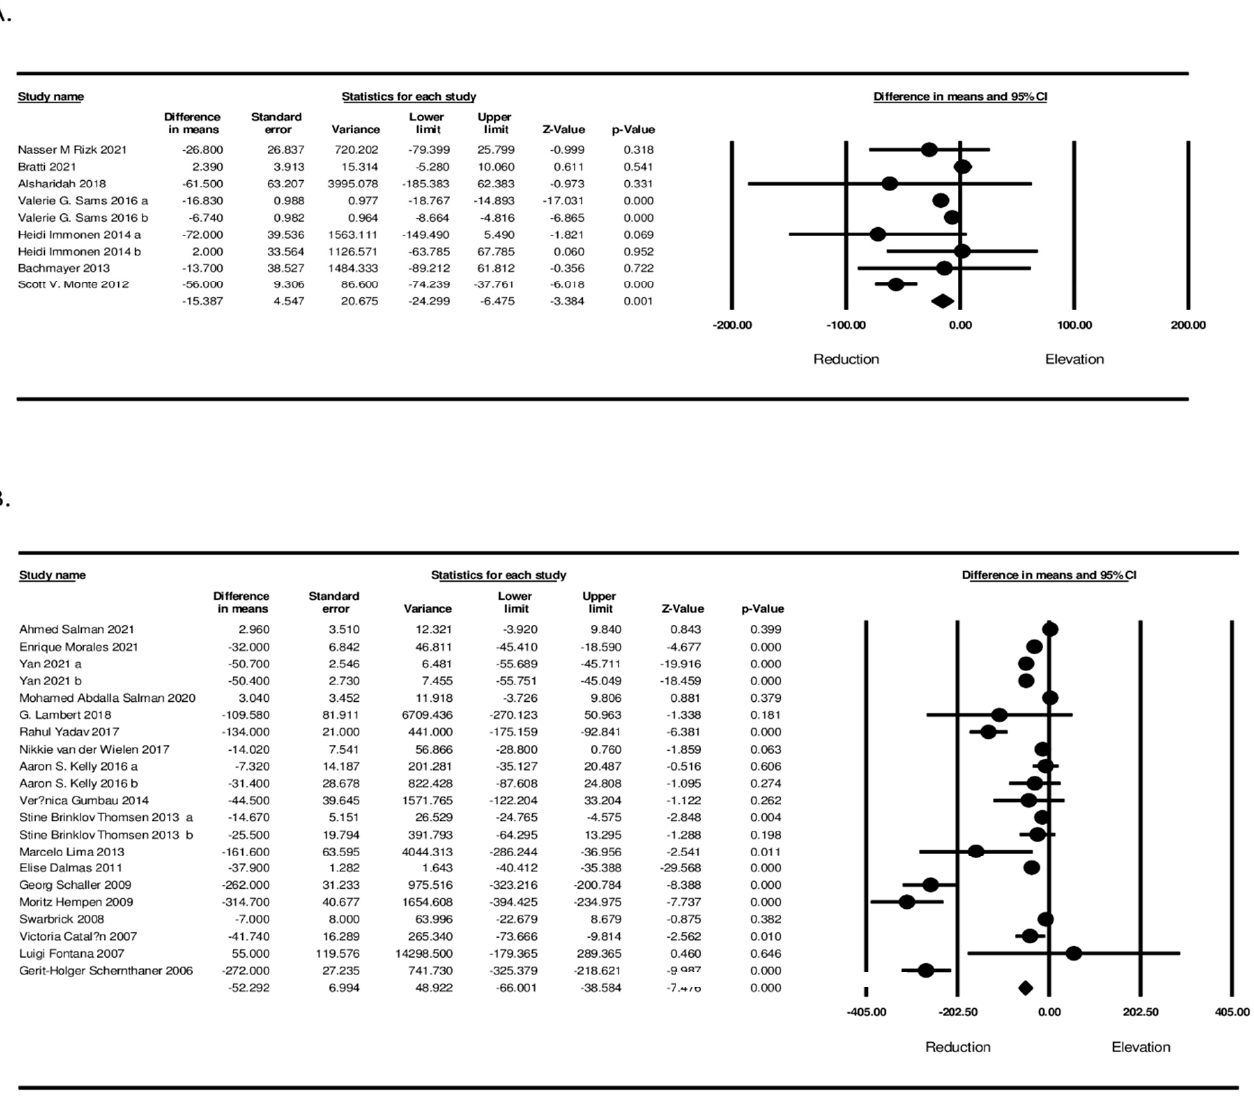
Figure 4. Subgroup analysis based on follow-up duration (( A ), less than 12 months), (( B ), equal or more than 12 months).